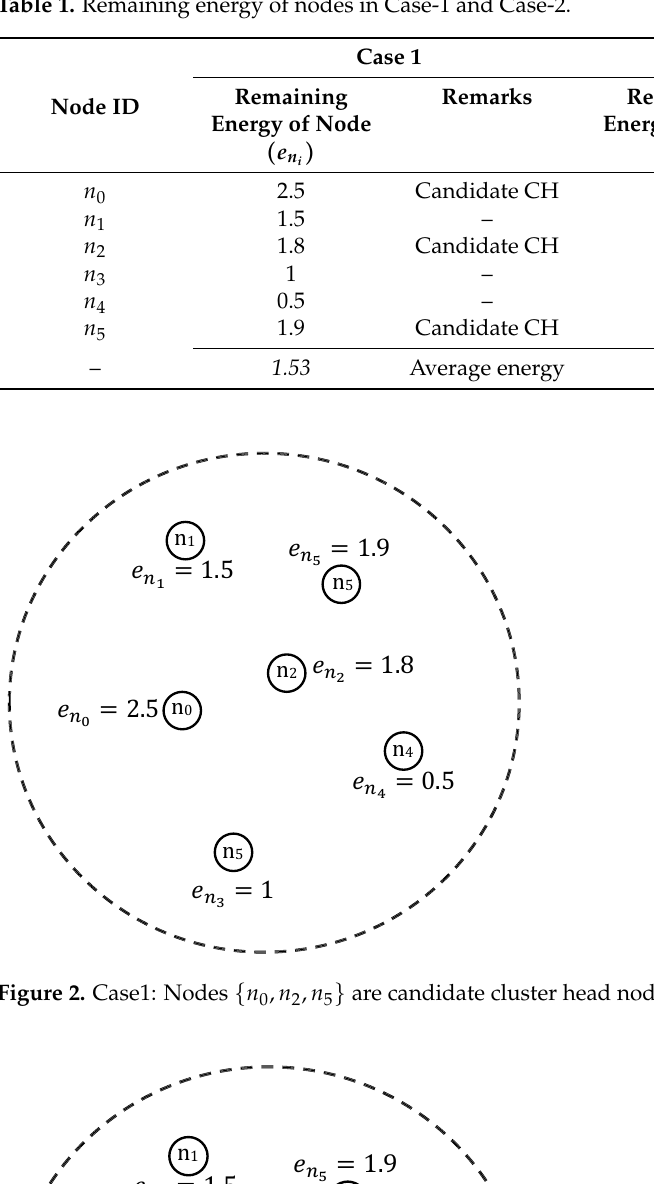
opt has to be estimated before network